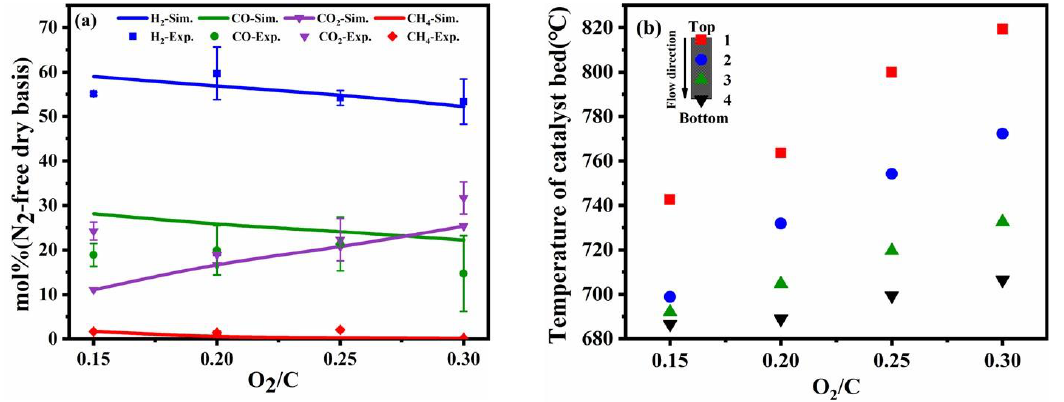
Figure 4. Comparison of experimental results and simulation results at different O 2 /C molar ratios ( a ), the different temperature distribution in the catalyst bed ( b ) (reaction condition: temperature